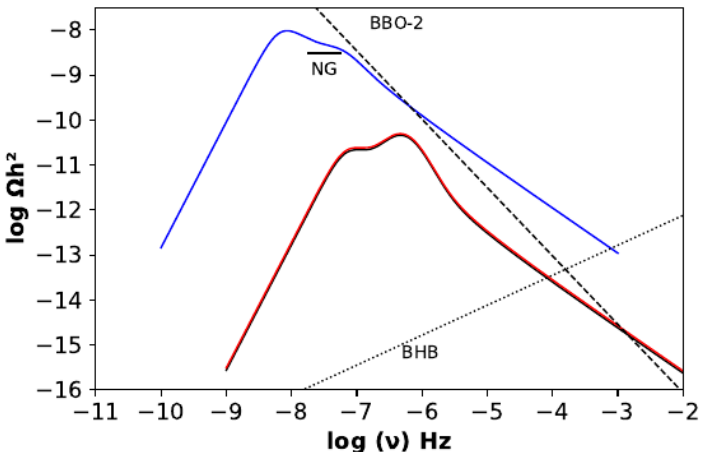
Figure 3. Cosmological gravitational wave background spectra generated during the QCD transition for different equations of state of the quark-gluon plasma: the blue curve corresponds to the bag- model, black and red continuous curves correspond respectively to models lat-1 and lat-2. Also included curves labeled BBO-2 and BHB, which correspond respectively to the sensitivity curve of the planned spatial antenna Big Bang Observer (version two) and to the expected astrophysical background of black holes binaries. The bar labeled NG indicates the possible detection by the NANOGrav